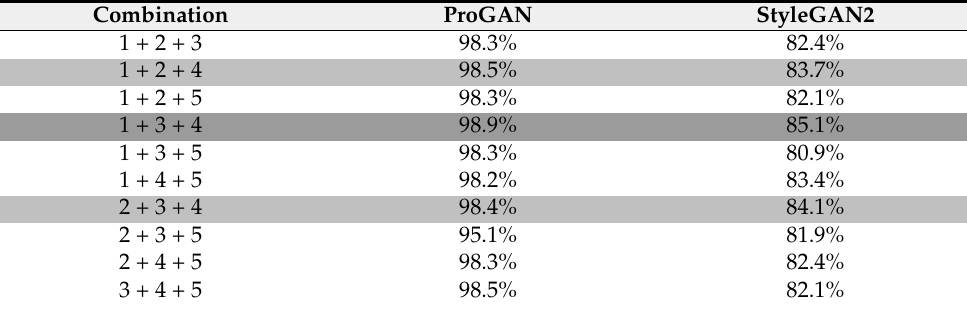
Table 1. Results of different